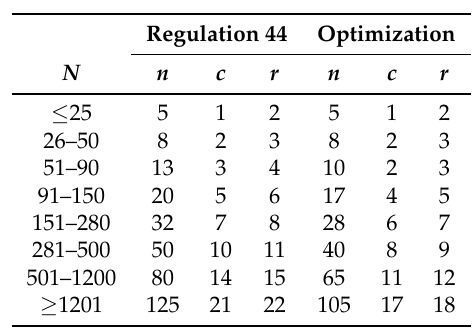
Table 1. Total units containing the sea urchins shown in Regulation 44 and optimization of the numbers of sea urchin boxes for sampling (modified version of the criteria shown in Regulation 44). For the samples obtained by Regulation 44, the sample size ( n ) and criteria of acceptance ( c ) and rejection ( r ) are according to the total units containing the sea urchins ( N , urchin boxes that disembark a boat or total boxes available in a processing